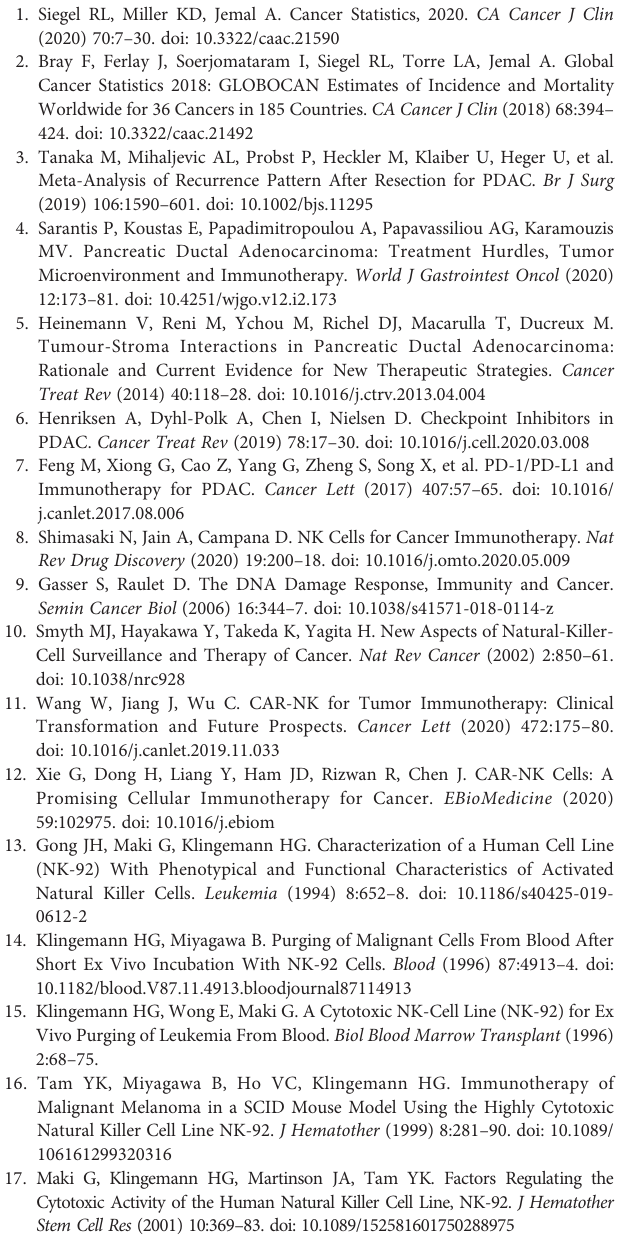
Supplementary Figure 3 | Effector and target cell preparation before in vivo experiments. (A) The PD-L1 expression of PD-L1 high MP cells was detected by FCM. (B) DetectionoftheproliferationactivityofNK92andSPcellsirradiatedwith g - irradiation at different doses. (C) Detection and statistical analysis of the killing effect of NK92 and SP cells on PD-L1 high MP before and after 10Gy g -irradiation (n=3, *P<0.0 5, **P<0.0 1, *P<0.001). (D) Comparation of the killing ability of NK92 cells and SP cells to PD-L1 high MP after irradiation.